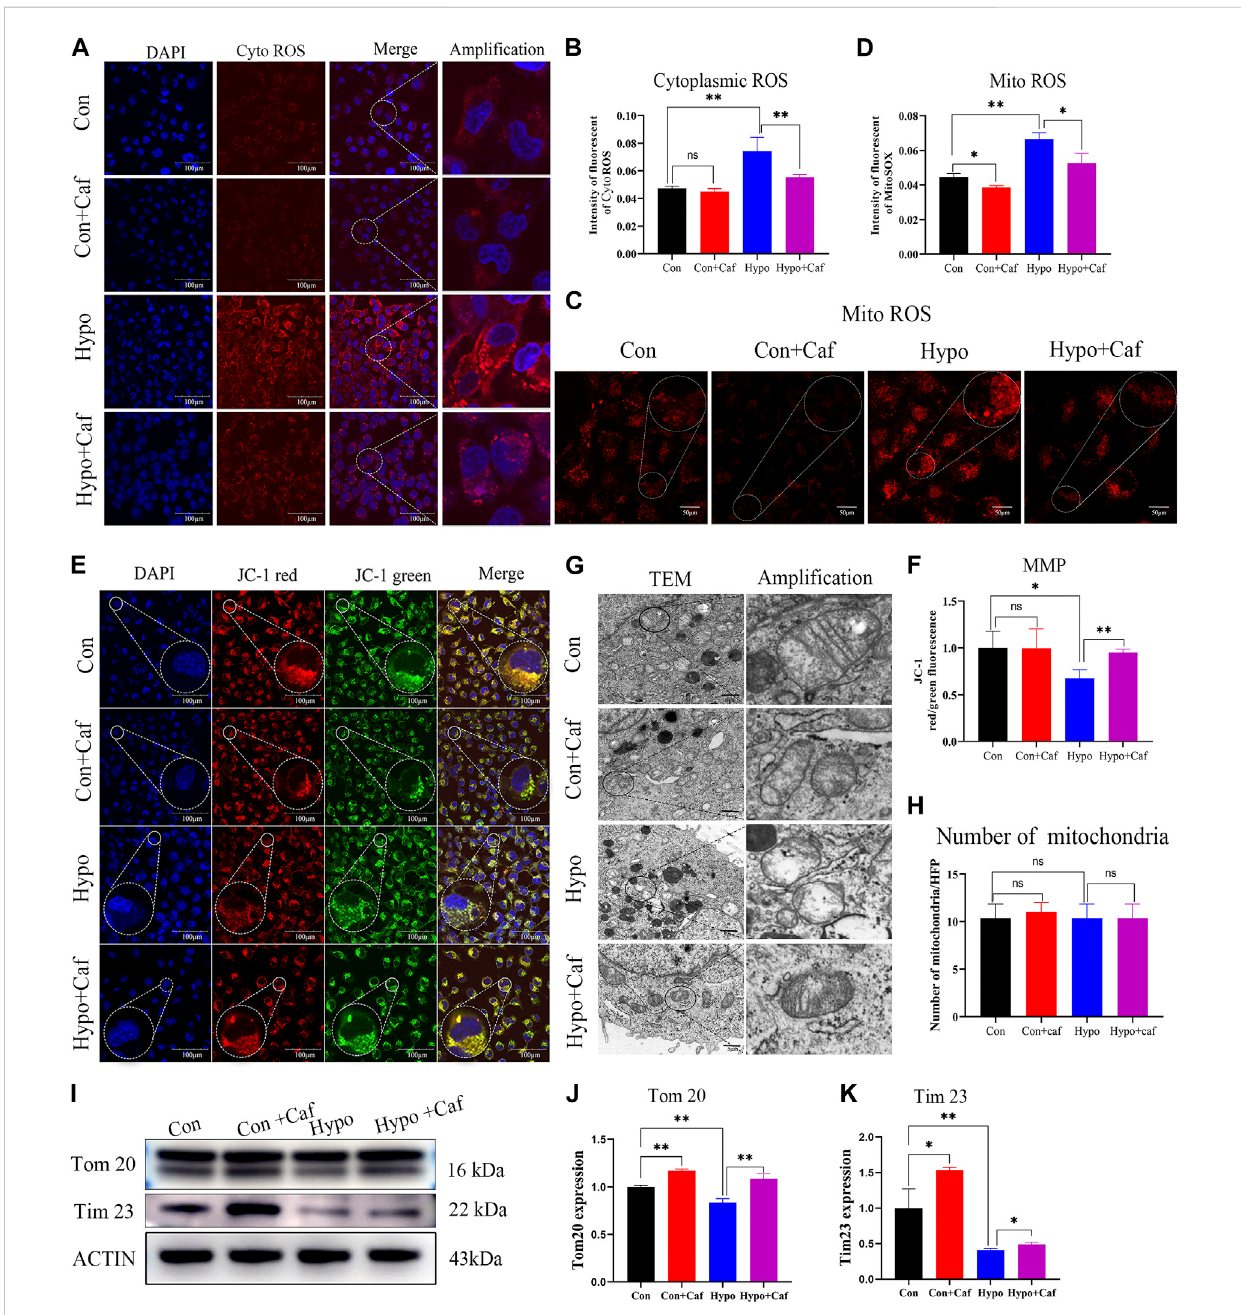
FIGURE 4 Caffeine reduces mitochondrial damage triggered by hypoxia and maintain mitochondrial morphology. (A, B) Confocal microscopy images of cytoplasmic ROS production (scale bars, 100 μ m). The cytoplasmic ROS was measured using a fl uorogenic probe (red), and the nucleus was marked by DAPI staining (blue). The intensity of fl uorescent ROS was calculated by ImageJ software. Hypoxia caused a substantial increase in ROS production, but caffeine suppressed this ROS accumulation. (C, D) Confocal microscopy images of mitochondrial ROS production (scale bars, 50 μ m). The mitochondrial ROS was detected by MitoSOX ™ Red mitochondrial superoxide indicator. Hypoxia caused a signi fi cant increase in mitochondrial ROS production, but caffeine suppressed this ROS accumulation. (E, F) Confocal microscopy images of MMP (scale bars, 100 μ m). MMP was measured using JC-1 reagent. The intensity of fl uorescent of MMP. MMP is indicated by a ratio of the red/green fl uorescence intensity. MMP decreased in hypoxia, while most mitochondria still have normal MMP in the caffeine group. (G) Representative transmission electron microscopy images of mitochondria at magni fi cation 12000. Scale bars represent 5 μ m. Mitochondria in the Hypo group showed more apparent cristae rare fi cation and swelling, wherein mitochondrial ultrastructure was severely disorganized. Caffeine can recover the conformation of mitochondria into normal in hypoxia. (H) The number of mitochondria per high-power fi eld in each group. The number of mitochondria per fi eld was counted and showed no difference in each group. (I – K) Representative Western blot images and summarized data of Tom20 and Tim23. ACTB was used as an internal reference. * p < 0.05, ** p <